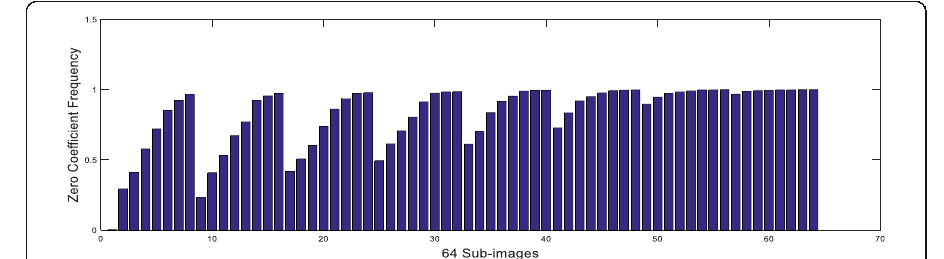
Fig. 3 Frequency of DCT coefficient 0 in each